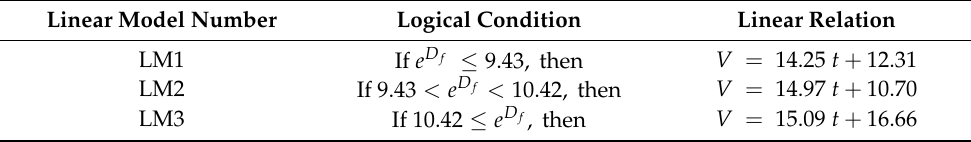
Table 5. The regression relationships proposed by the M5